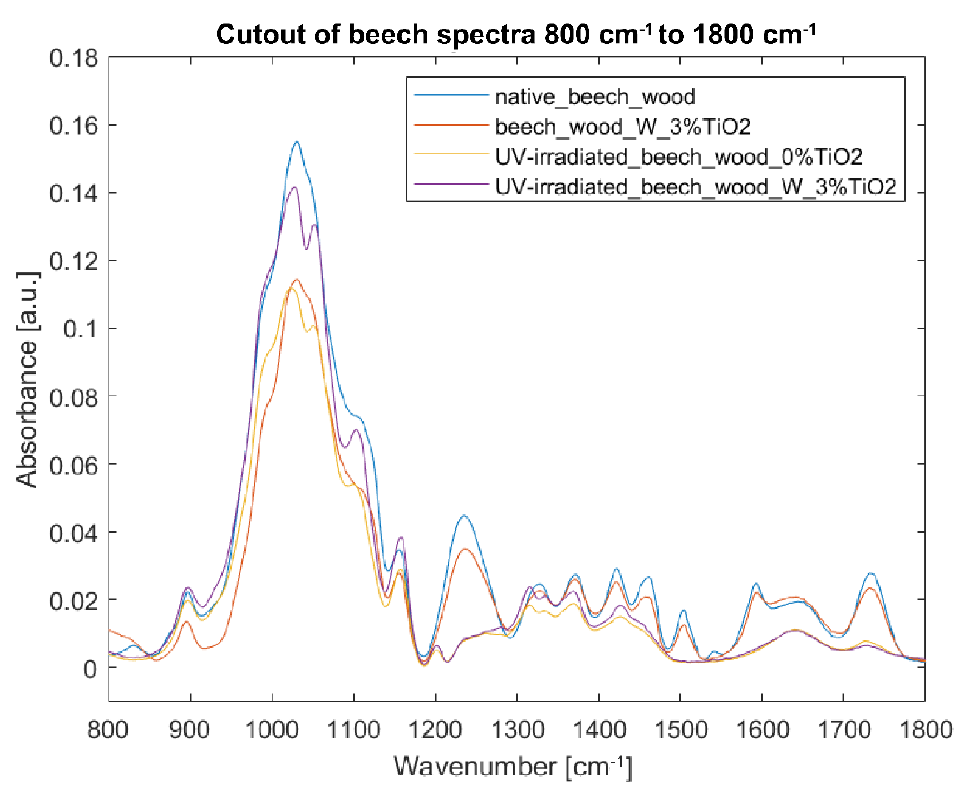
Figure 8. FTIR-ATR spectra of beech wood samples in the fingerprint region 800–1800 cm − 1 : (blue) reference sample of native beech wood, (red) beech wood with 3% TiO 2 coating with water as binder, (yellow) UV-irradiated beech wood without TiO 2 coating, and (purple) UV-irradiated beech wood with 3% TiO 2 coating with water as